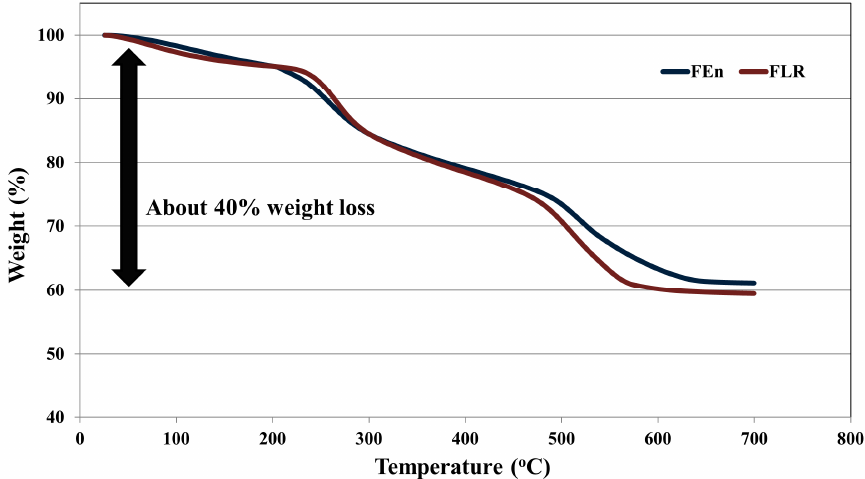
Figure 12. Thermal gravimetric analysis (TGA) curves of the foulant samples acquired from the lead position FEn and FLR elements.